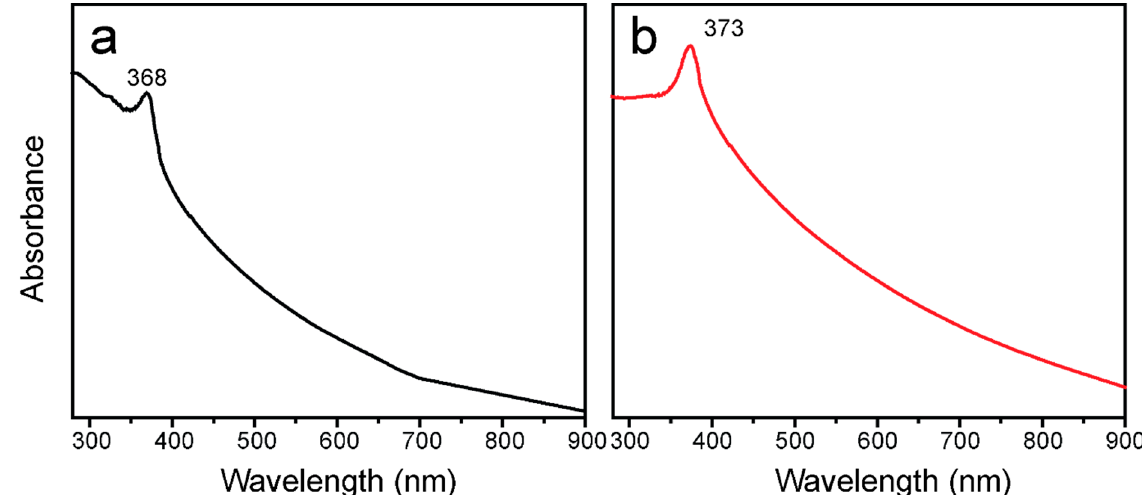
Figure 5. UV–vis absorption spectra of ( a ) ZnO and ( b ) N-doped ZnO.